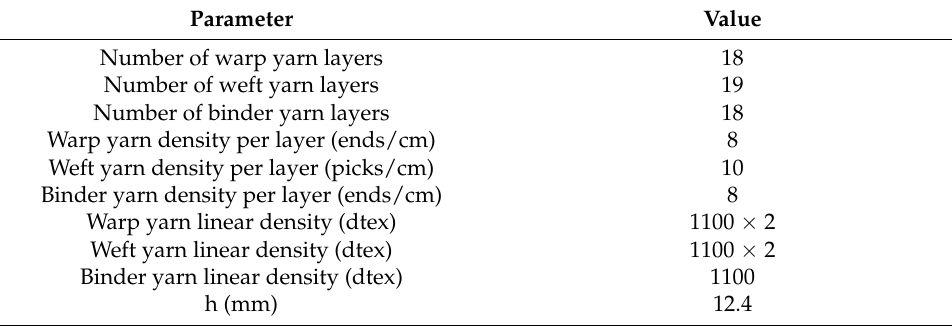
Table 1. Specifications of the 3DWP.